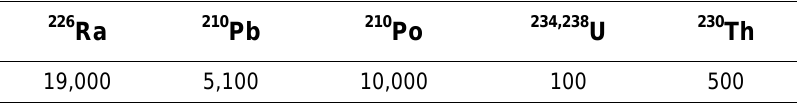
CRs (L kg –1 ) for Radionuclides of the Uranium Series in V. angasi , Determined from Samples Collected in the